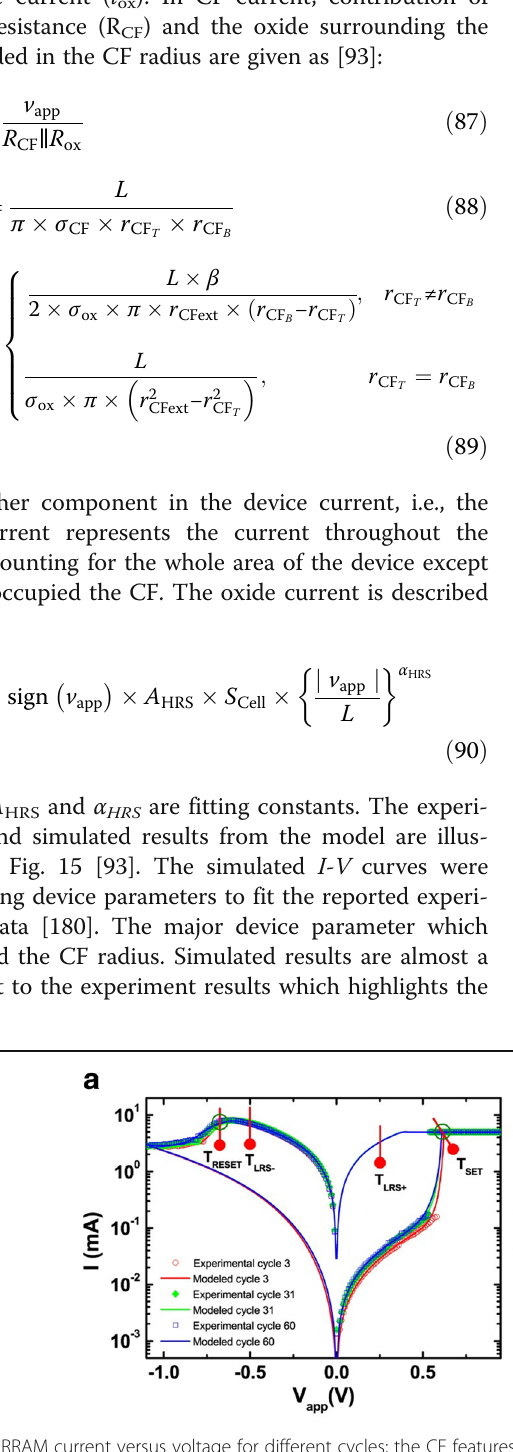
Fig. 15 a RRAM current versus voltage for different cycles; the CF features are tuned to fit different curves such as r CFTM = 45 nm, r CFTm = 15 nm, and r CFBM = 7 nm for cycle 3, r CFTM = 45 nm, r CFTm = 25 nm, and r CFBM = 7 nm for cycle 31, and r CFTM = 40 nm, r CFTm = 35 nm, and r CFBM = 7.8 nm for cycle 60; b I - V curves for the devices under consideration along with different modeled data (the CFs ’ dimensions considered to fit the whole set of curves have been generated randomly). The temperature at the most representative points of the I – V curve, highlighted in a cycle 3: T SET (T,B) =[579,656] K, T LRS+ (T,B) =[349,368] K, T LRS-(T,B) =[466,525] K, T RESET (T,B) =[565,621] K; cycle 31: T SET (T,B) =[573,669] K, T LRS+ (T,B) =[349,368] K, T LRS- (T,B) =[460,525] K, T RESET (T,B) =[566,622] K; cycle 60: T SET (T,B) =[564,685] K, T LRS+ (T,B) =[347,367] K, T LRS- (T,B) =[460,525] K, T RESET (T,B) =[545,641] K